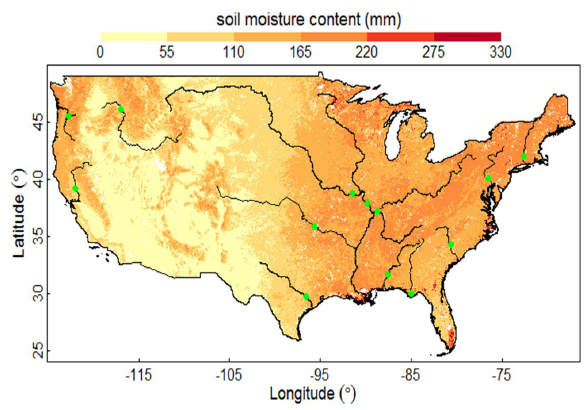
Fig. 5. LH-simulated 26-yr (1981–2006) mean annual soil moisture in the top 50cm of soil layers.